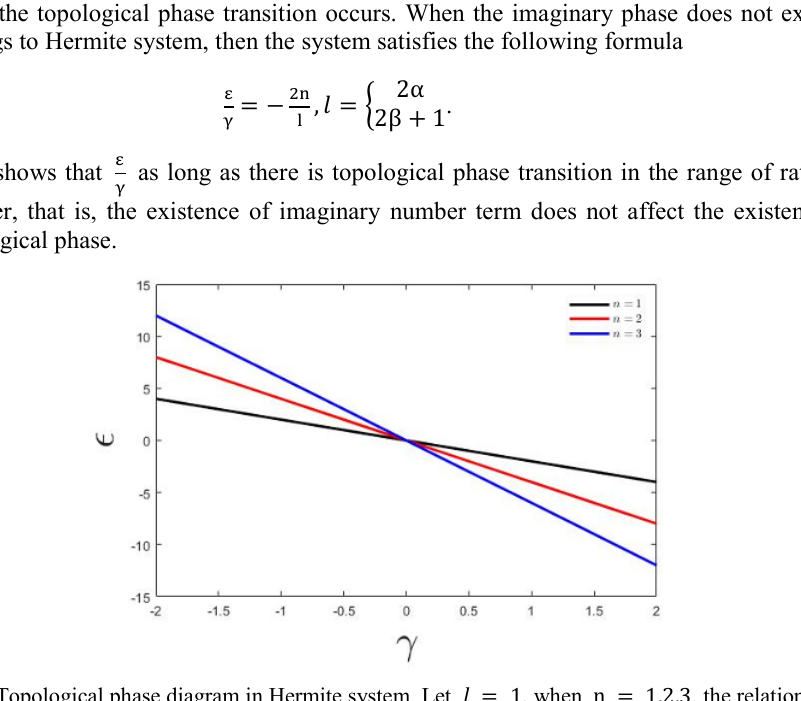
Fig. 3. Topological phase diagram in Hermite system. Let between dielectric constant a and dissipation parameter B is shown in the